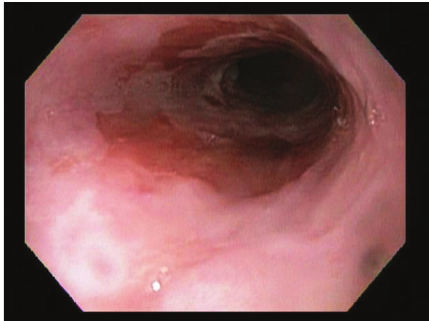
Figure 3: Periodic acid-Schiff-Alcian blue stain (pH 2.5), 20x . The monomorphic cells were highlighted by a periodic acid-Schiff (PAS) stain; note the dark blue inhomogeneous staining of intracytoplas- mic mucin in the intestinal-type metaplastic goblet cells, which is characteristic in Barrett mucosa.